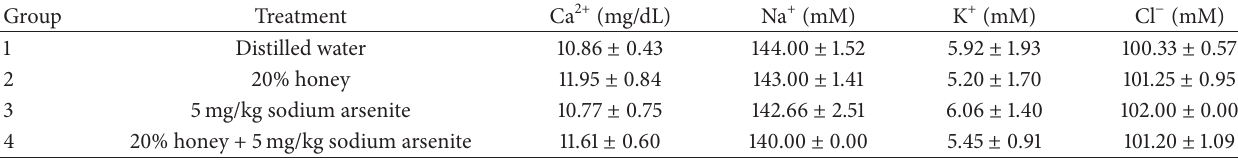
Table 3: The electrolyte levels in serum after Acacia honey and sodium arsenite administration in vivo .